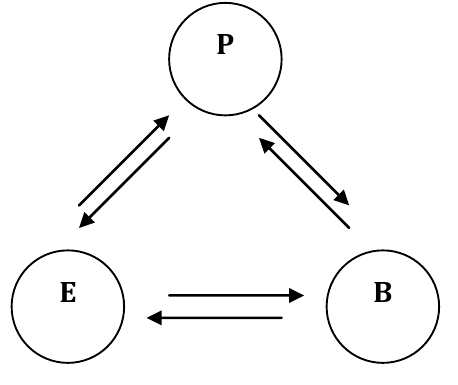
Figure 1 . The model of triadic reciprocal causality (Bandura,